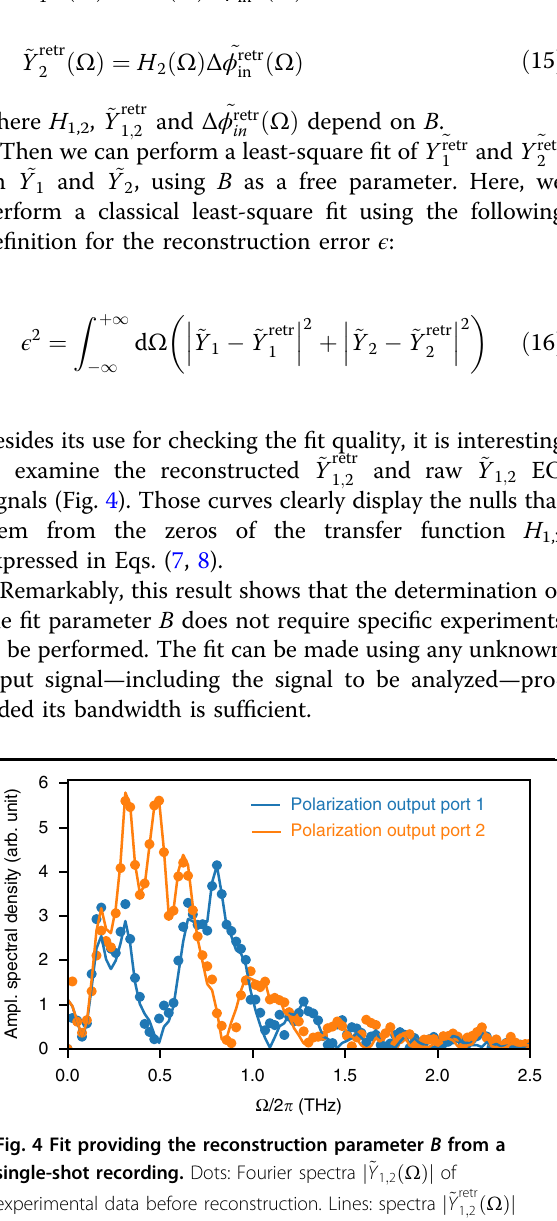
ð Ω Þj 1 ; 2 ð Ω Þ are fi tted on ~ Y ð Ω Þ 1 ; 2 1 ; 2